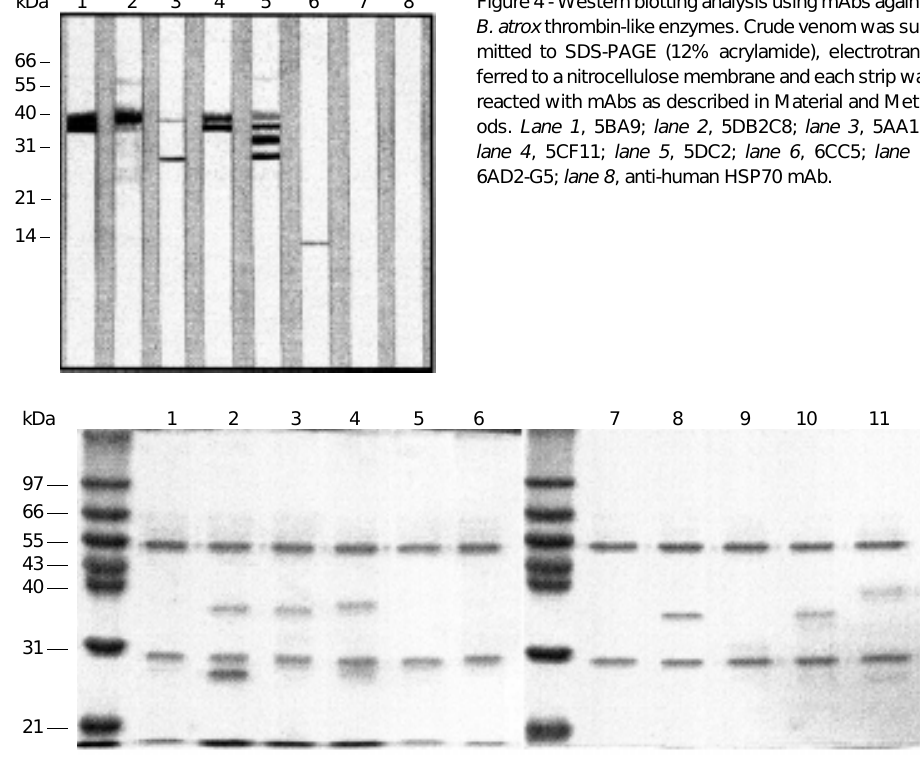
Figure 4 - Western blotting analysis using mAbs against B. atrox thrombin-like enzymes. Crude venom was sub- mitted to SDS-PAGE (12% acrylamide), electrotrans- ferred to a nitrocellulose membrane and each strip was reacted with mAbs as described in Material and Meth- ods. Lane 1 , 5BA9; lane 2 , 5DB2C8; lane 3 , 5AA10;